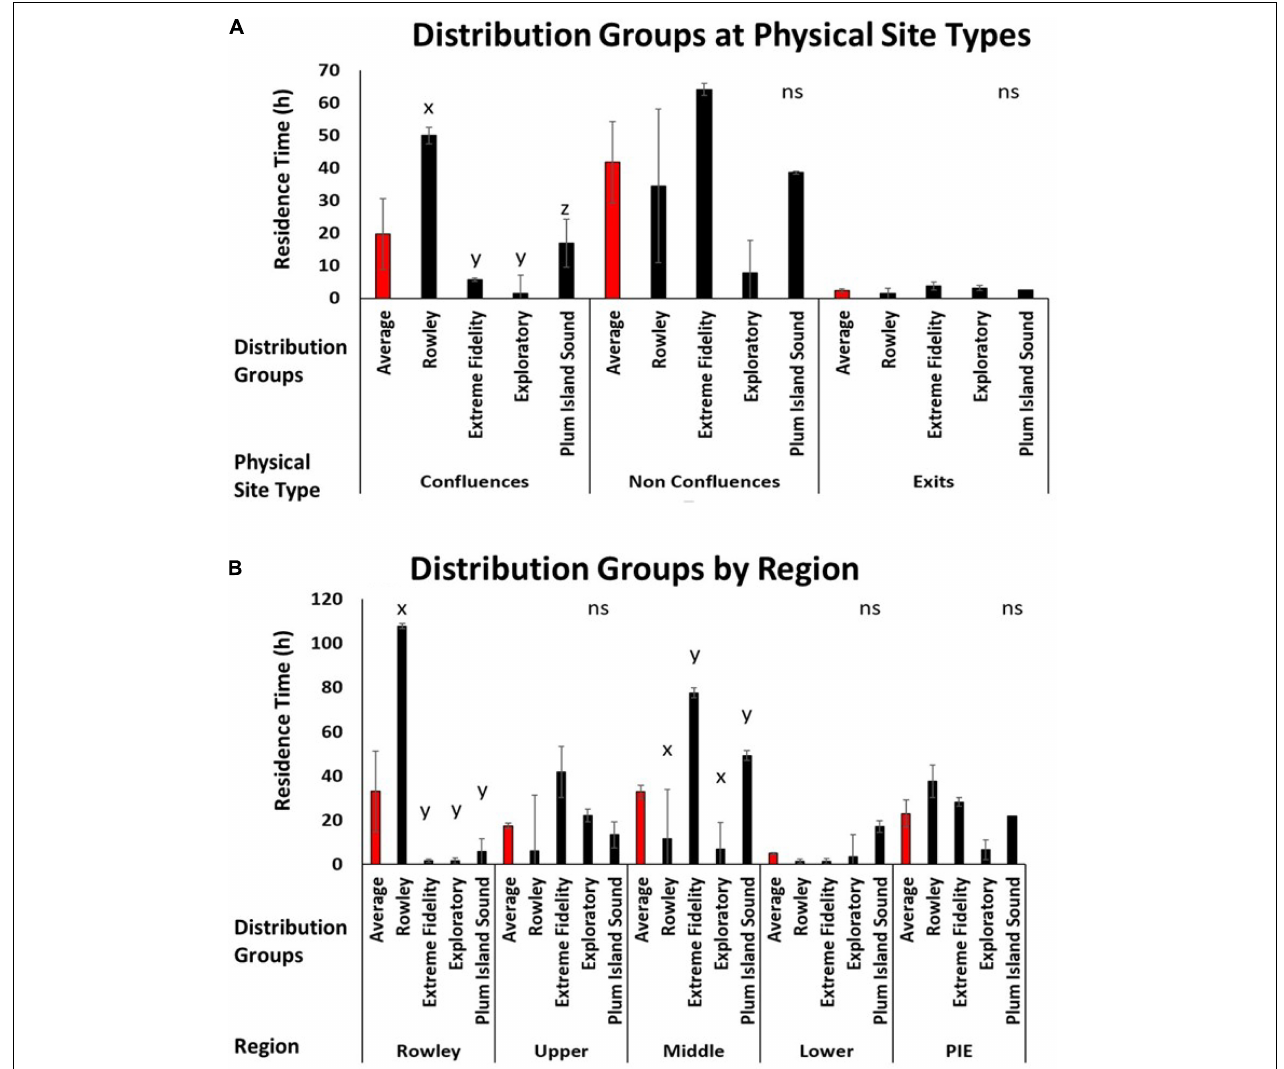
FIGURE 5 | (A) Bar graphs depicting the average residence time (h) ( Y axis) for each cluster group (Rowley, Extreme Fidelity, Exploratory, and Plum Island Sound; X axis) by physical site types (confluence, non-confluence, and exit; X axis). (B) Bar graphs depicting the average residence time (h) ( Y axis) for each distribution group ( X axis) by region (Rowley River, Upper Sound, Middle Sound, and Lower Sound) and the whole estuary average (PIE) ( X axis). Letters indicate statistical differences.